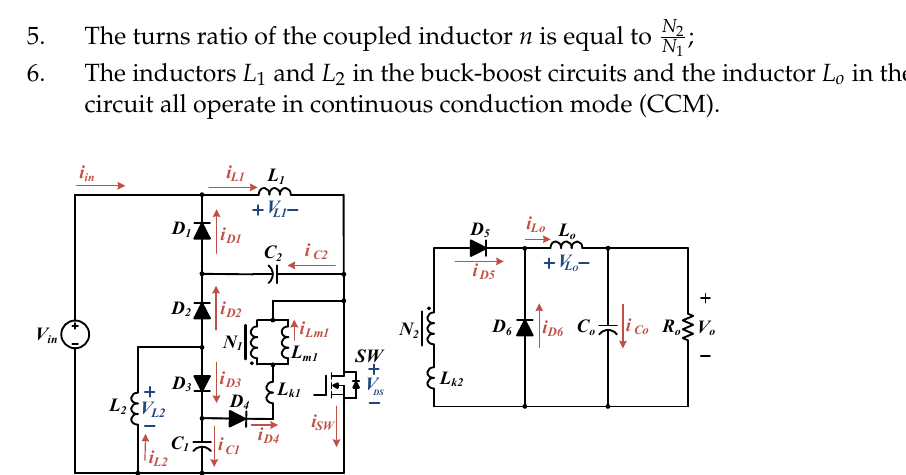
Figure 5. Conceptual key waveforms of the converter in the CCM situation.